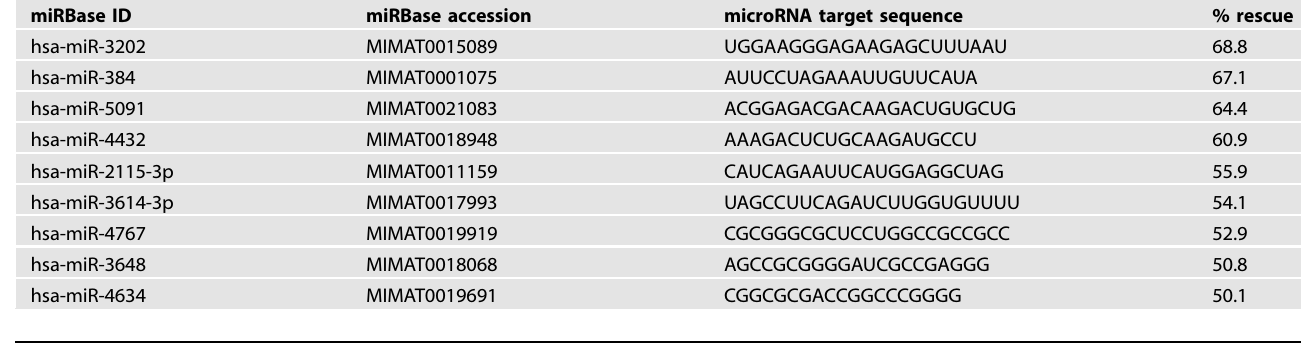
Table 2. List of the top toxic miR